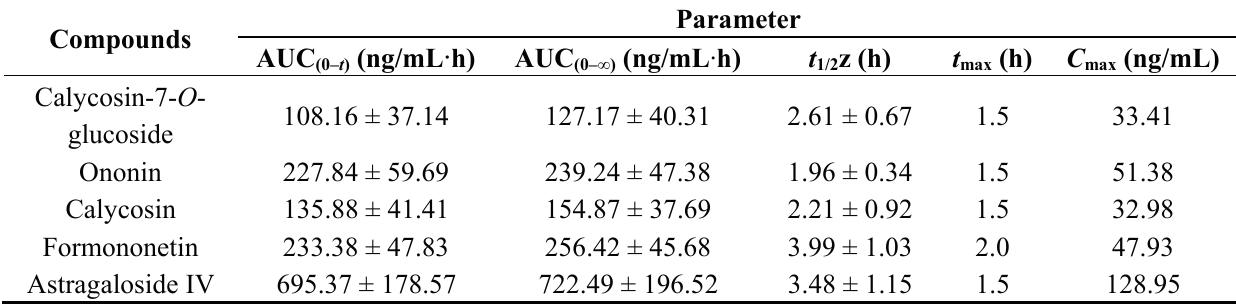
Table 3. The pharmacokinetic parameter of calycosin-7- O -glucoside, ononin, calycosin, formononetin and astragaloside IV.